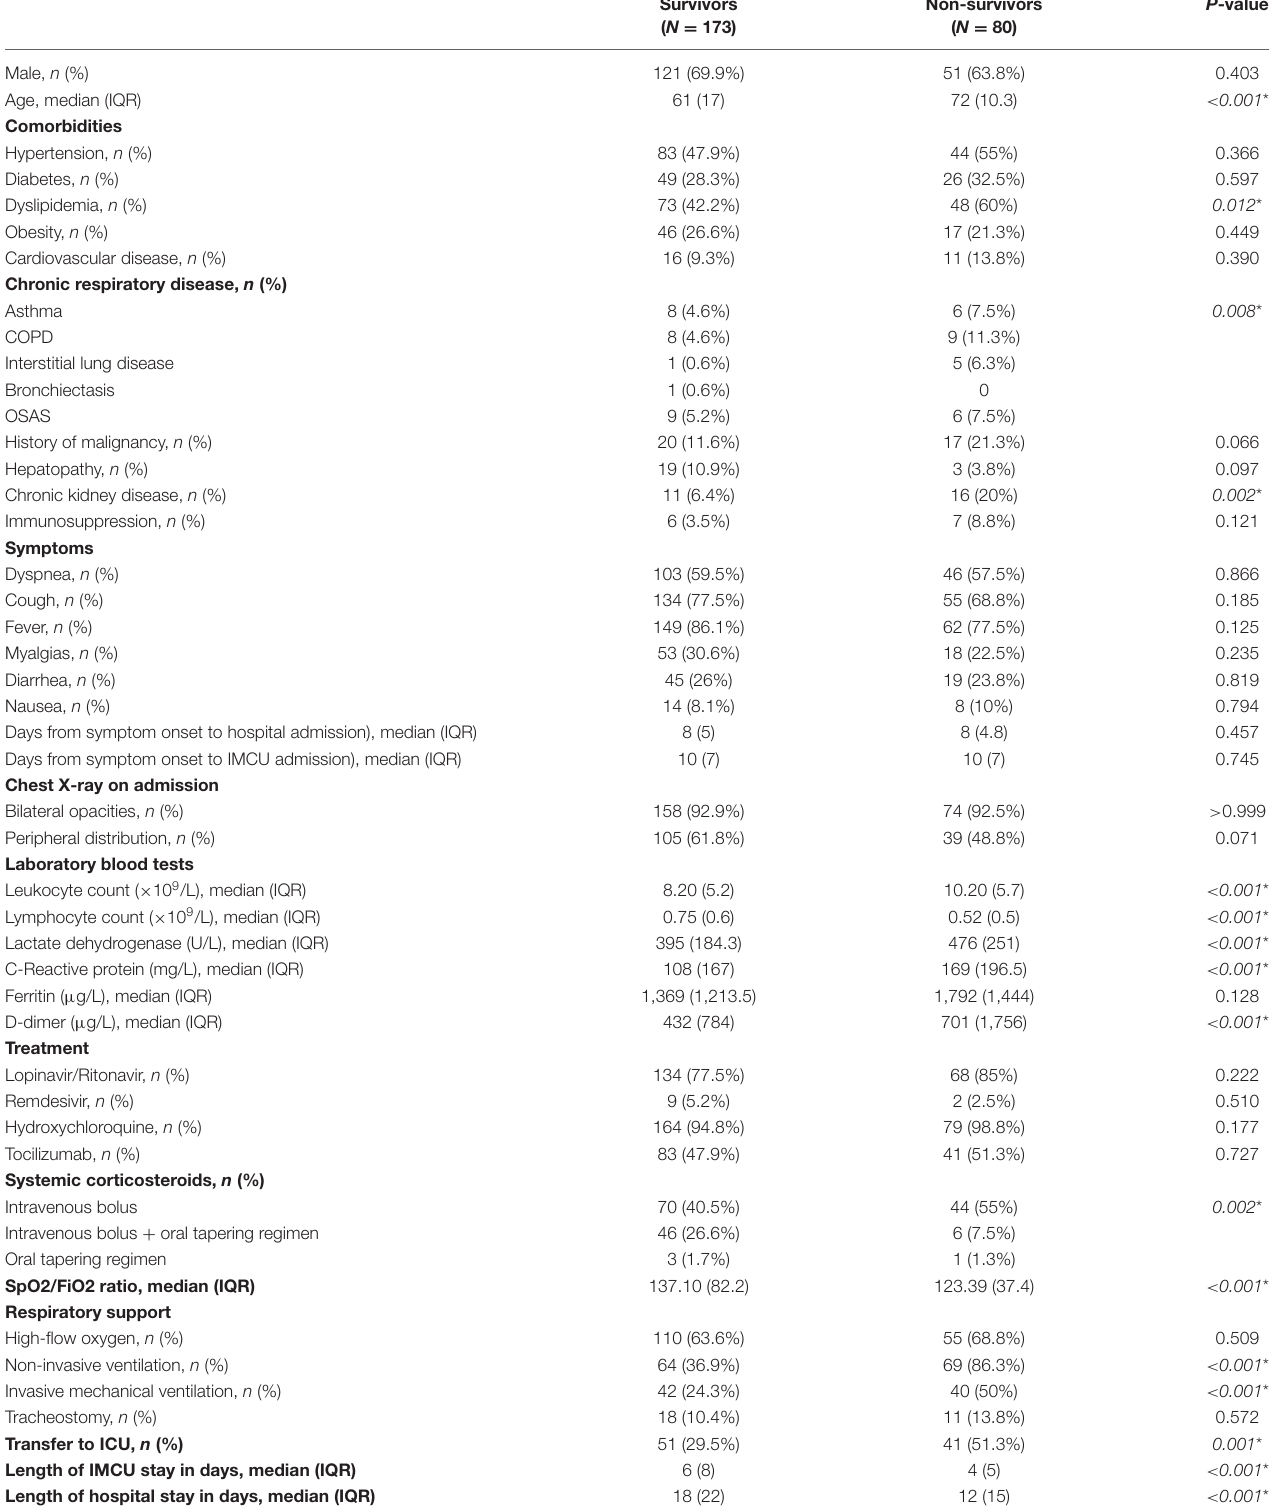
TABLE 3 | Patient characteristics regarding in-hospital